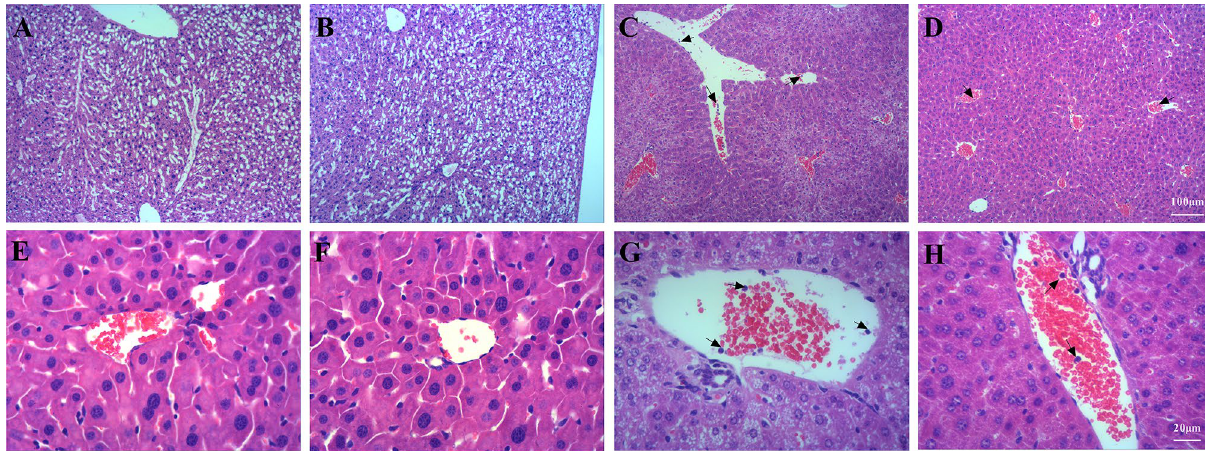
Figure 4. A photomicrograph of liver tissues used for morphological analysis. ( A ) Con group, ( B ) LPS group, ( C ) Ex group, ( D ) Ex + LPS group. White arrows indicate neutrophils [( A – D) × 100 magnification; ( E – H ) × 400